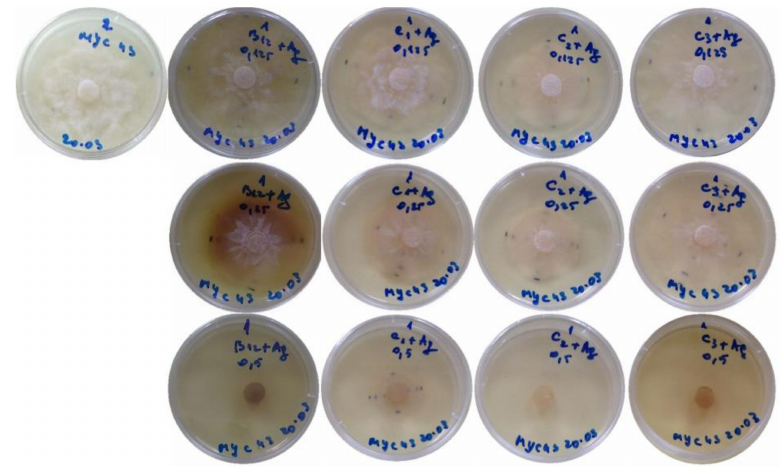
Figure 1. Phytophthora cinnamomi growth inhibition assays with the nanocomposites based on the chitosan oligomers in hydroalcoholic solution preparation medium. From left to right : Control (no treatment) and treatments with AgNPs combined with gallic acid, silymarin, ferulic acid and curcumin inclusion compounds. From top to bottom : 125 µ g · mL − 1 , 250 µ g · mL − 1 , and 500 µ g · mL − 1 concentrations. Only one repetition per treatment is shown.